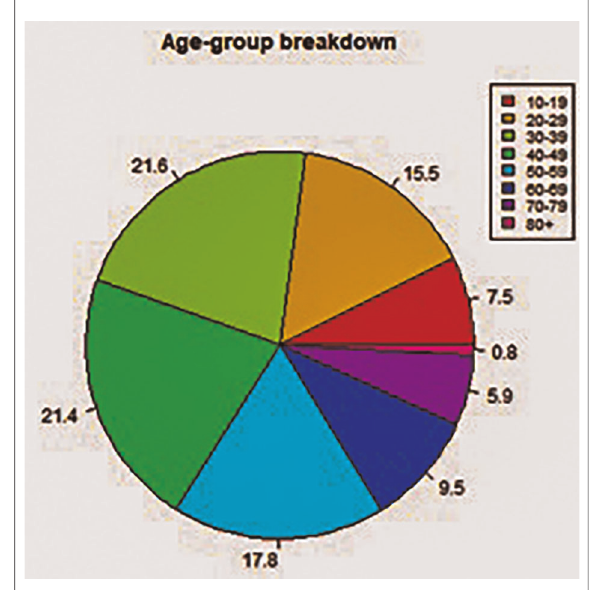
FIGURE 3 Gender breakdown of deaths by suicide during the period 2008 – 2017 in County Cork.